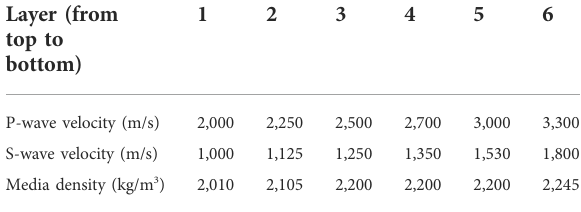
TABLE1Wavevelocitiesandmediadensitiesof2-Dgeologicalmodel. Layer (from top to